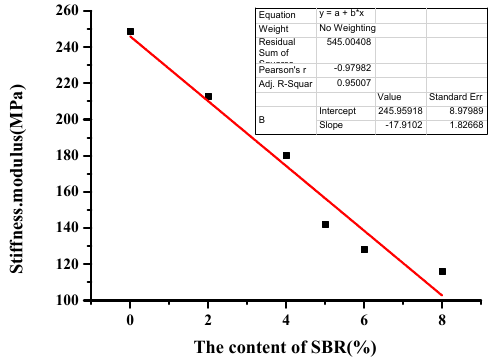
Figure 7. Fitting curves of SBR content and ductility.